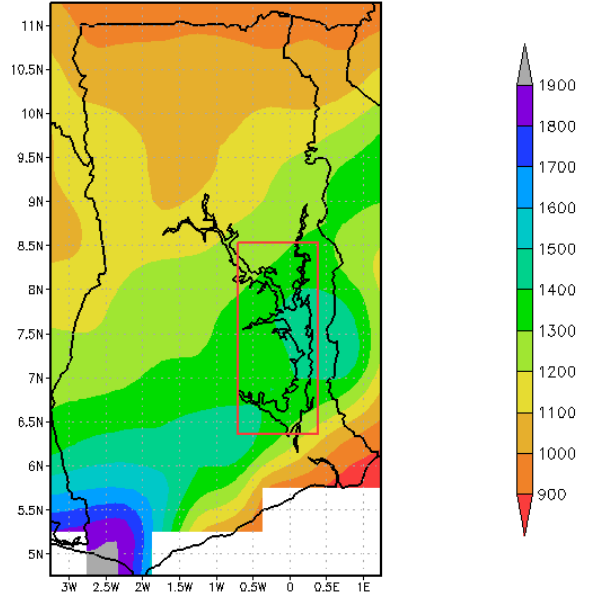
Figure 7. Mean annual total rainfall (mm) over Ghana for the period 1901–2010. Location of the Volta basin indicated by the red